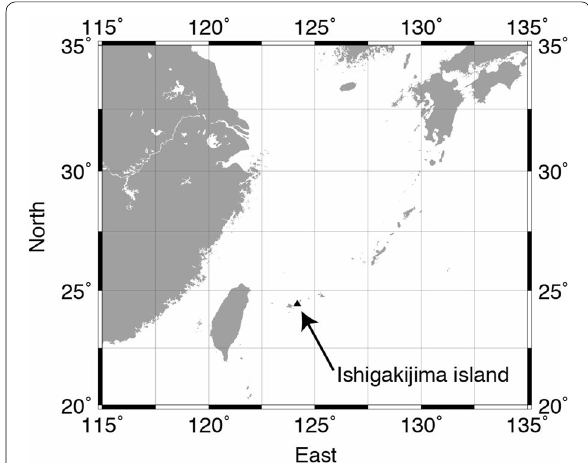
Fig. 2 Location of Ishigakijima Island, Japan, where the supercon‑ ducting gravimeter CT #036 was